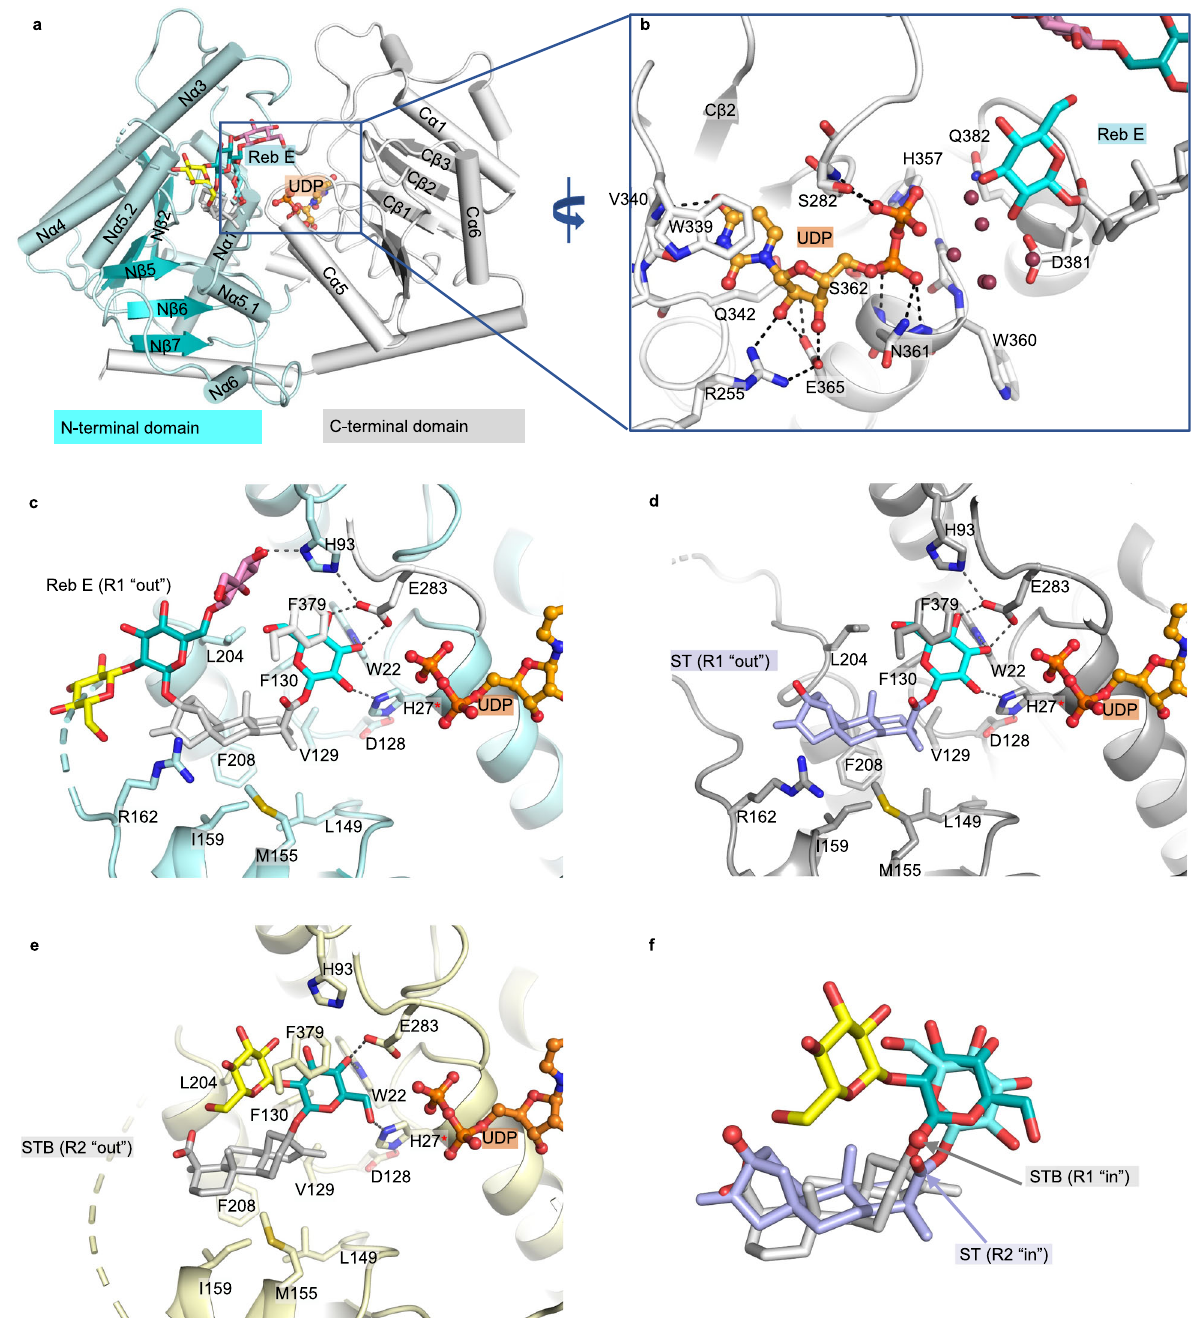
Fig. 3 Structure of OsUGT91C1 and the binding modes to recognize substrate. a Overall structure of OsUGT91C1. The structure is shown in cartoon representation with the N-terminus domain colored cyan and the C-terminus white. The bound UDP is shown in stick-ball mode with carbon colored orange, oxygen red, and nitrogen blue. The steviol compound derived from Reb E is shown in stick with carbons of the steviol aglycone colored white, while carbons of the glycan are colored differently, carbons of glucose 1-R2 in cyan, glucose 1-R1 in dark cyan, glucose 2-1-R1 in yellow, and glucose 6-1-R1 in pink. b Binding of UDP mainly involves the C-terminal domain with the hydrogen bonds shown by dashed lines. A cluster of water molecules, shown as red balls, fi lls the space most likely occupied by the glucose of UDP-glucose. c , d Binding of the steviol compounds Reb E ( c ) and ST ( d ) with the R2 end at the active site and the R1 end at the “ out ” site. e Binding of the steviol compound STB with the R1 end at the active site and the R2 end at the “ out ” site. The catalytic His27 is marked with a red asterisk in c – e . f Comparison of two binding modes using ST (the R2 end at the active site, denoted as R2 “ in ” ) and STB (the R1 end at the active site, denoted as R1 “ in ”